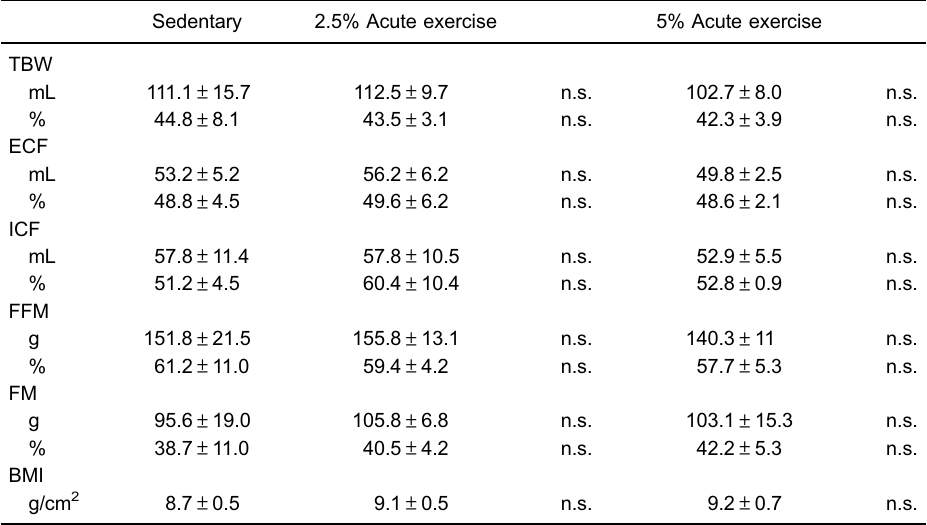
Table 1. Evaluation of body composition by the bioimpedance spectroscopy (BIS) method in rats that were subjected to the sedentary or acute exercise (2.5% or 5%) protocols.